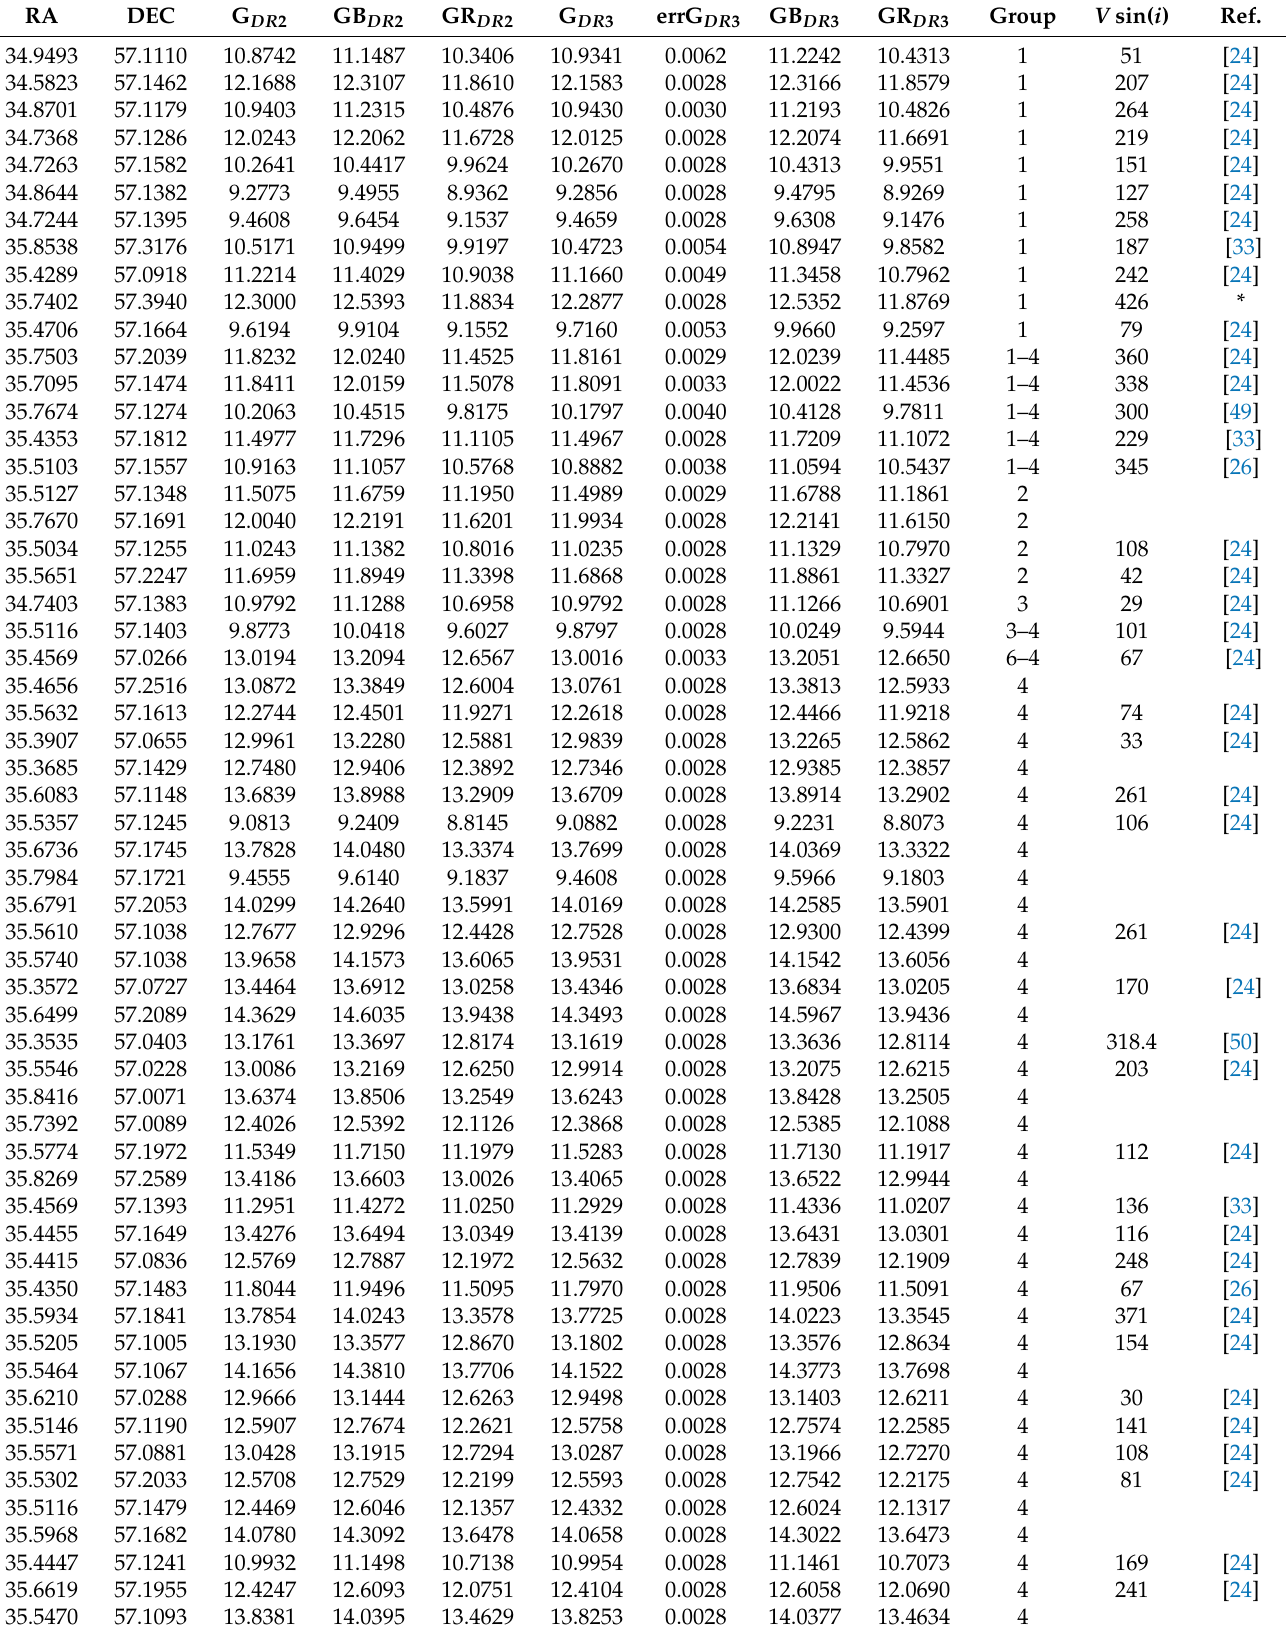
Table A1. Relevant data for variable stars of the Double Cluster. See text for a